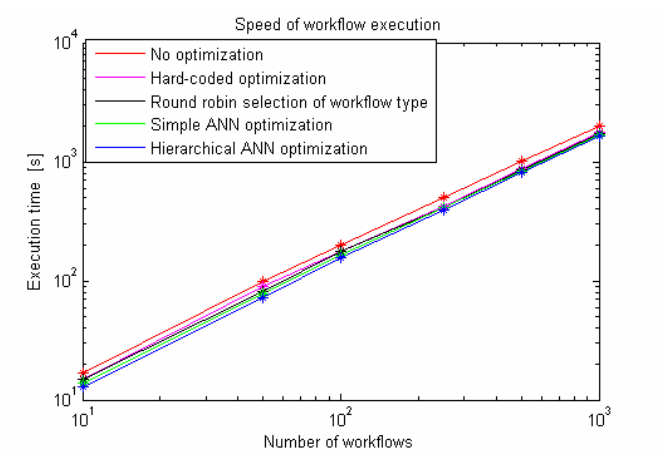
Fig. 5. Speed of workflow execution